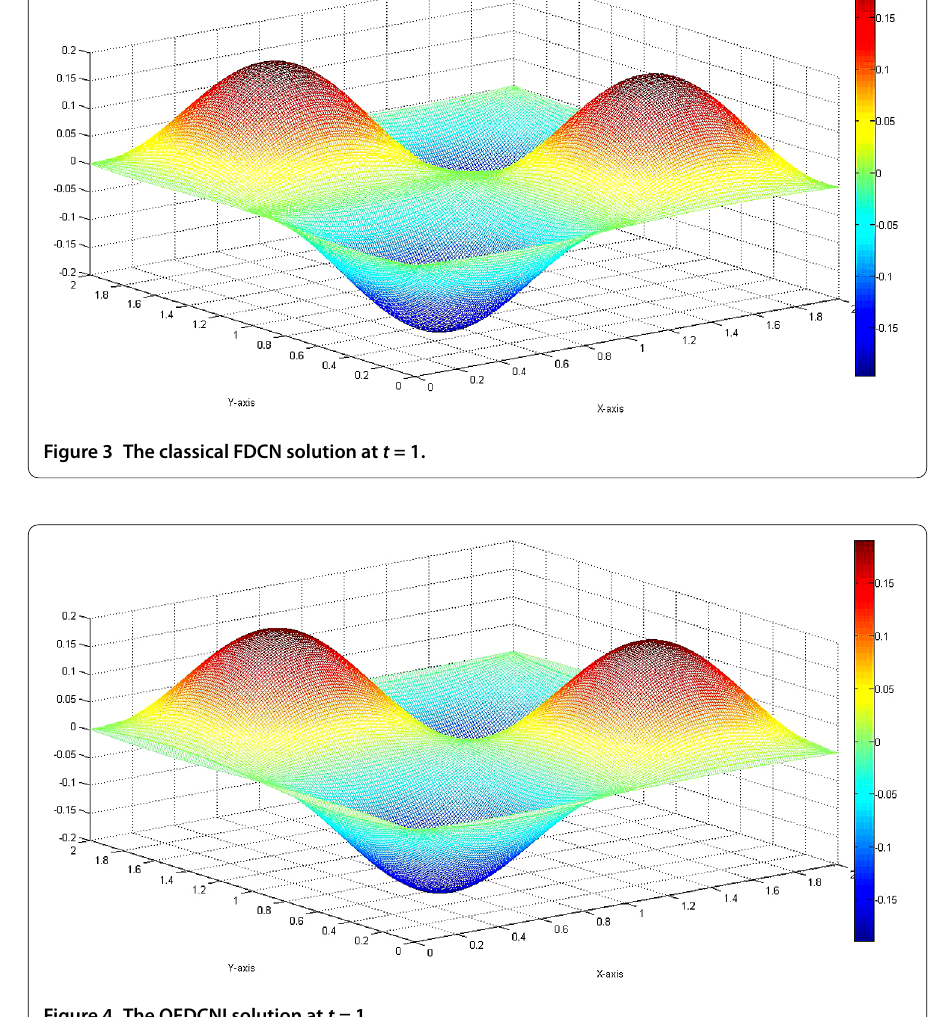
Figure 4 The OFDCNI solution at t =